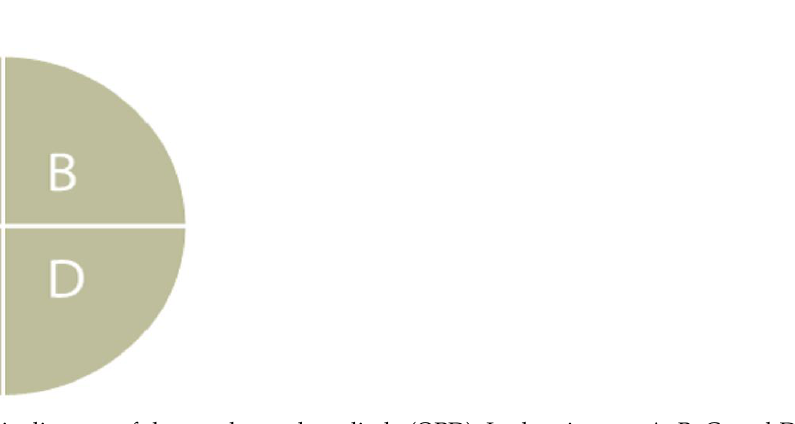
Figure 2. Schematic diagram of the quadrant photodiode (QPD). In the pictures, A, B, C, and D represent the valid integral regions in the four Cartesian coordinate quadrants.